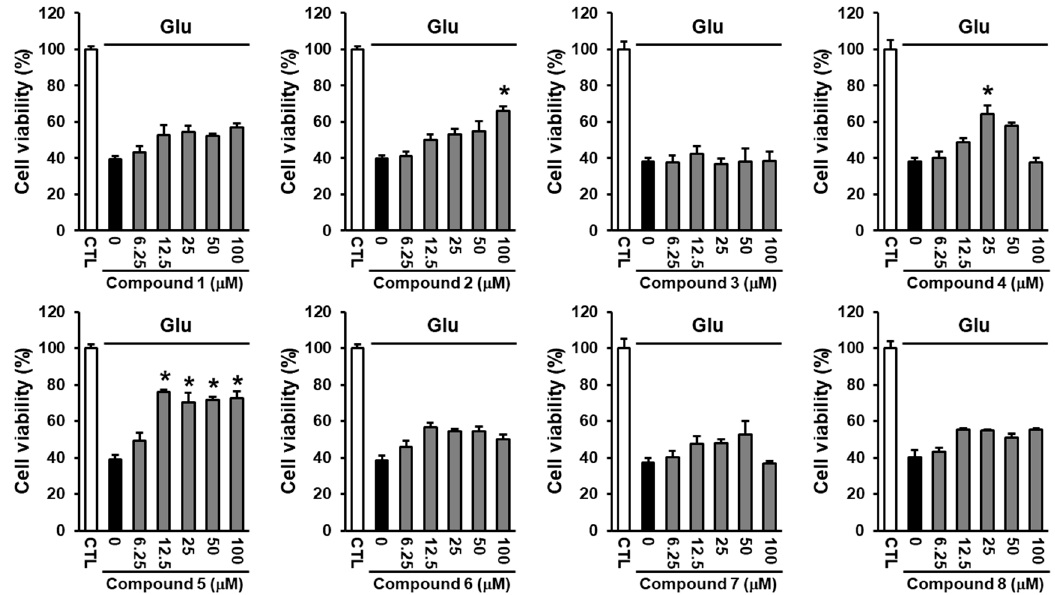
Figure 4. Neuroprotective effects of the isoflavonoids isolated from the termite-associated Streptomyces sp. RB1 in HT22 cells. The cells were treated with 5 mM glutamate and the indicated concentrations of compounds 1 – 8 (mean ± S.E.M., * p < 0.05 compared with glutamate-treated cells). Cell viability assays were done in triplicate for each assay and repeated at least three times.